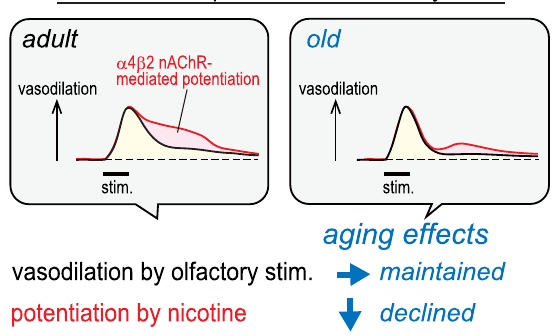
Fig. 4 Schematic diagram showing aging effects on α4β2 nAChR-mediated potentiation of vasodilation within the olfactory bulb. nAChR, nicotinic acetylcholine